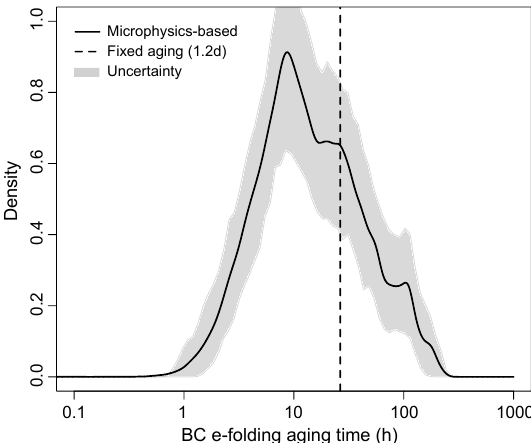
Figure 3. Probability density function of simulated annual mean BC e -folding aging time (h) over the globe for a microphysics-based scheme (solid line) and a fixed aging scheme (dashed line). Also shown is the 95% uncertainty range (in grey) of the microphysics- based aging time estimated from a Monte Carlo